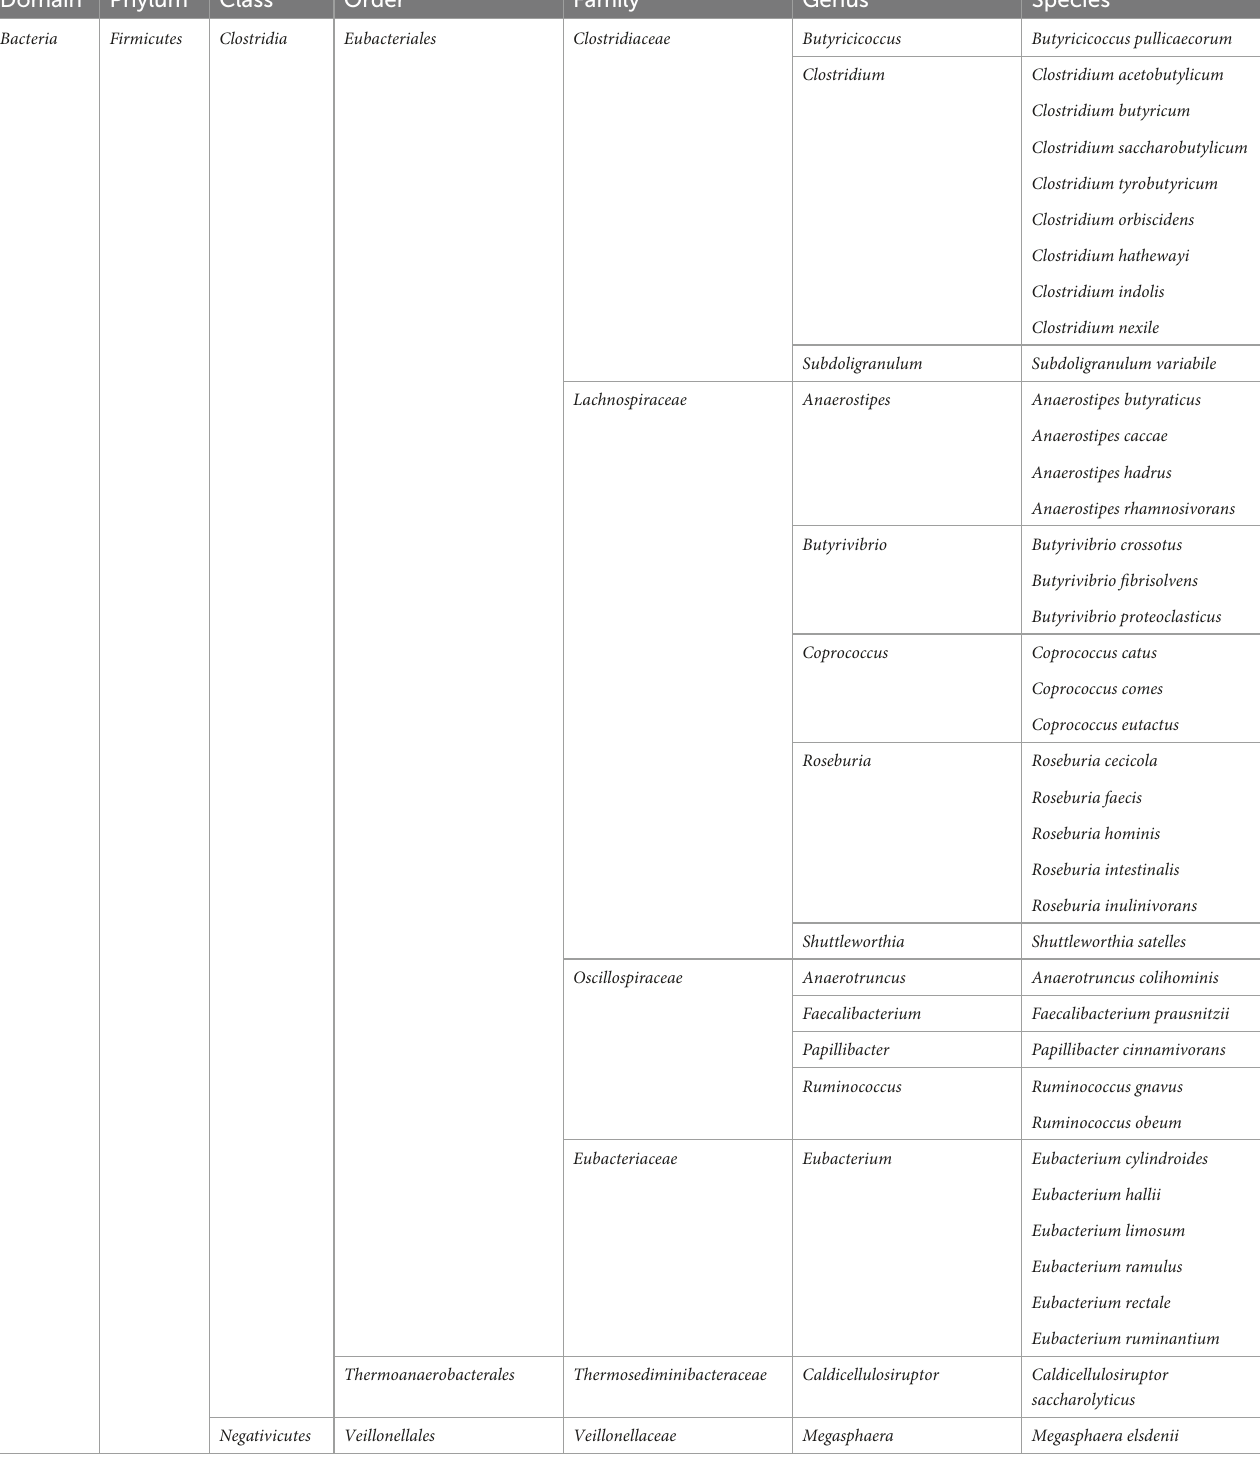
TABLE 1 The butyrate-producing